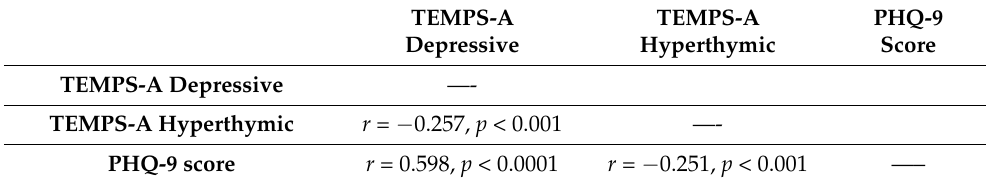
Table 3. Significant correlations between two TEMPS-A scales and the total score on the PHQ-9.